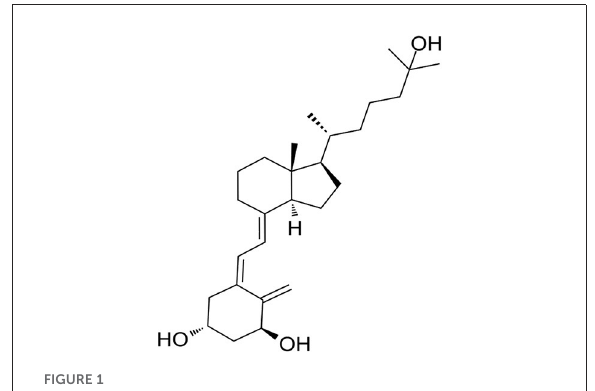
FIGURE1 The 2-dimensional structure of 1,25-dihydroxyvitamin D.